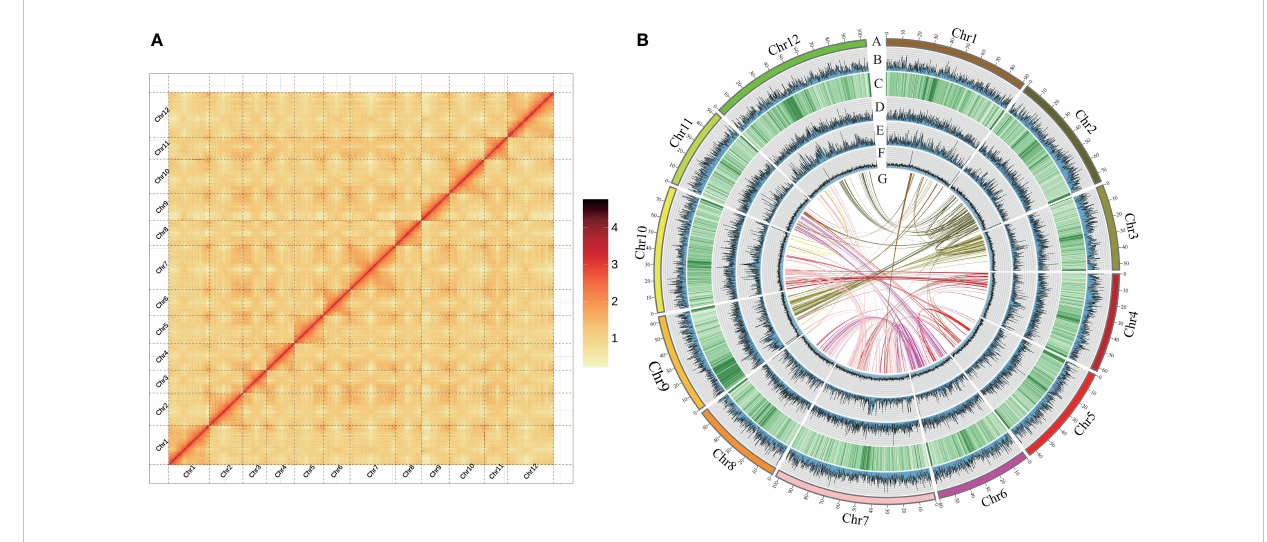
FIGURE 1 Features of Castanopsis hystrix genome. (A) Genome-wide analysis of chromatin interactions in the C hystrix genome based on Hi-C data. (B) The Synteny and distribution of genomic features. (A) The 12 pseudochromosomes; (B) gene density; (C – E) the density of total repeat sequences, Gypsy LTR-RTs, and Copia LTR-RTs; (F) histogram of GC content; (G) intragenomic collinearity. (B – F) were drawn in 100 kb overlapping sliding